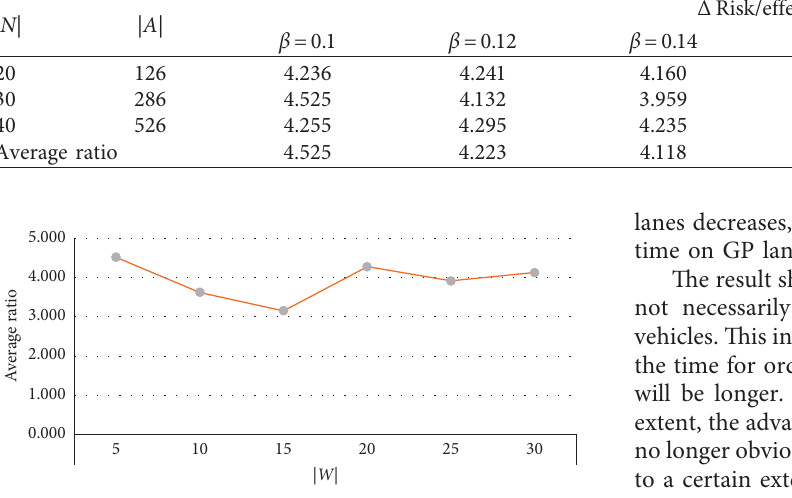
Figure 9: The trend of the average ratio as | W | increases.